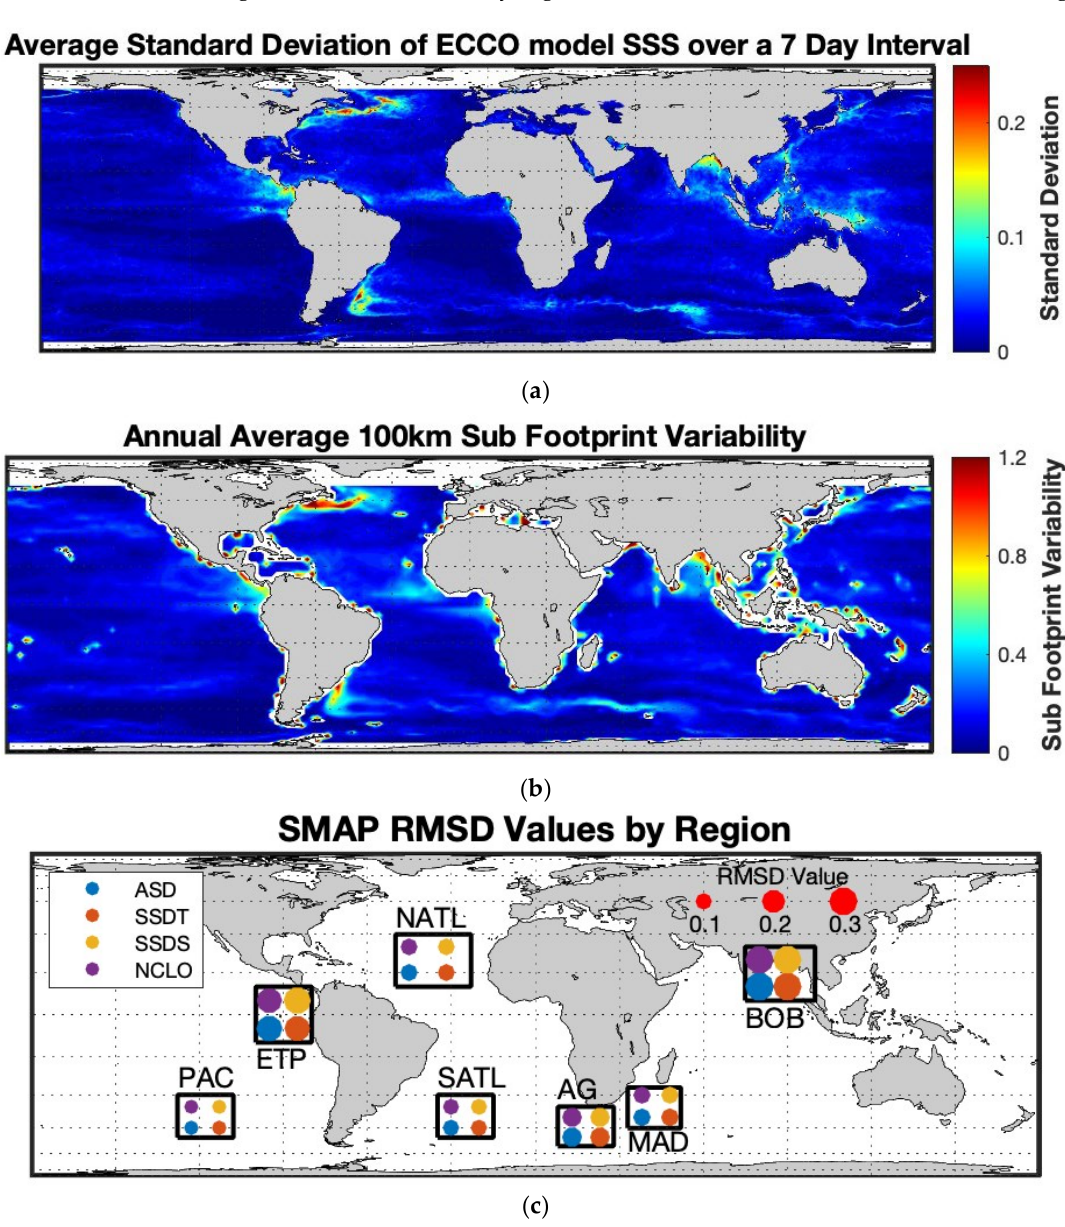
Figure 12. ( a ) gives the average variability of SSS over a 7-day interval on a 1/48° grid. This gives an idea of the short-term variability of the ECCO model. ( b ) gives the daily average 100 km sub-footprint variability (calculated using the method in [24] on a 2° × 2° evaluation grid. This gives an idea of the small-scale spatial variability of the ECCO model. ( c ) A representation of the data from Figure 6a on a map showing the boundaries of the regions studied. The regions that have high variability shown in Figure 12a,b have high RMSD values produced by all methods.